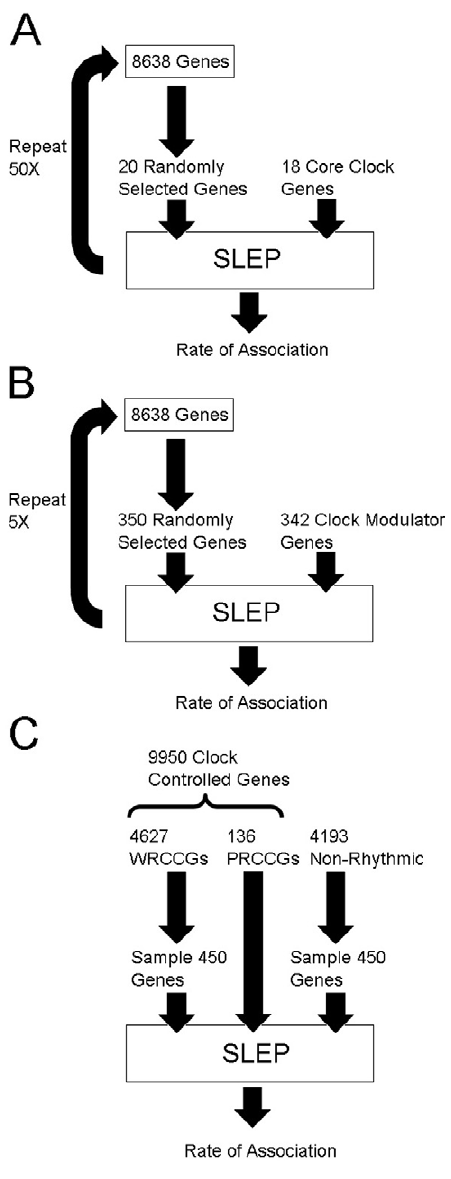
Figure 2. The method for clock gene and random gene analysis is summarized for three test sets. The rate of association in SLEP was determined for sets of randomly selected genes that contained gene numbers similar to A) core clock genes and B) clock modulator genes. C) Pervasively rhythmic (PRCCGs), weakly rhythmic (WRCCGs) and non-rhythmic genes were directly compared. Of 9950 clock controlled genes, 5187 were rhythmic in 2–5 tissues. Genes of intermediate rhythmicity were not examined.